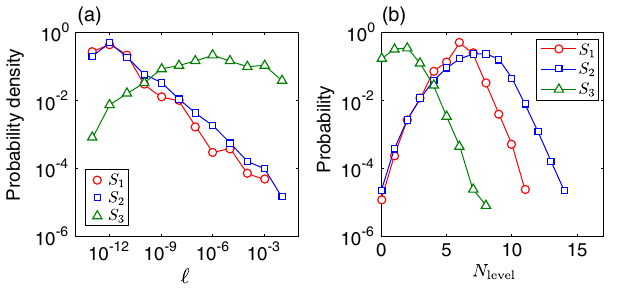
FIG. 8. Distribution of fractality measures for the roulette system computed from the 2 20 ≈ 1 . 05 × 10 6 grid points used in Figs. 4(d) – 4(f). (a) Estimated probability density function for the fractality length scale l . (b) Estimated probability mass function for the construction level N level